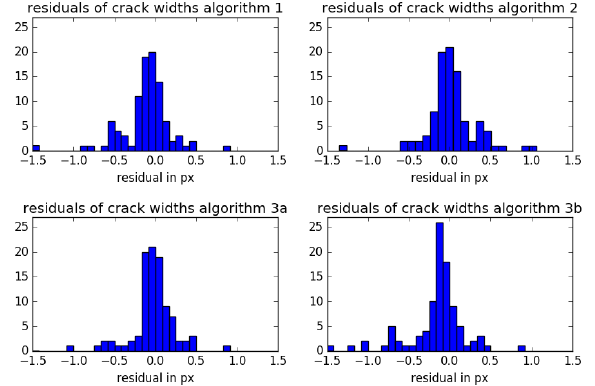
Figure 16. White points: manually set points being perpendicular to the crack; colored points: points set on the crack manually; color-code is computed by the differences of distances between the white points compared to the reference